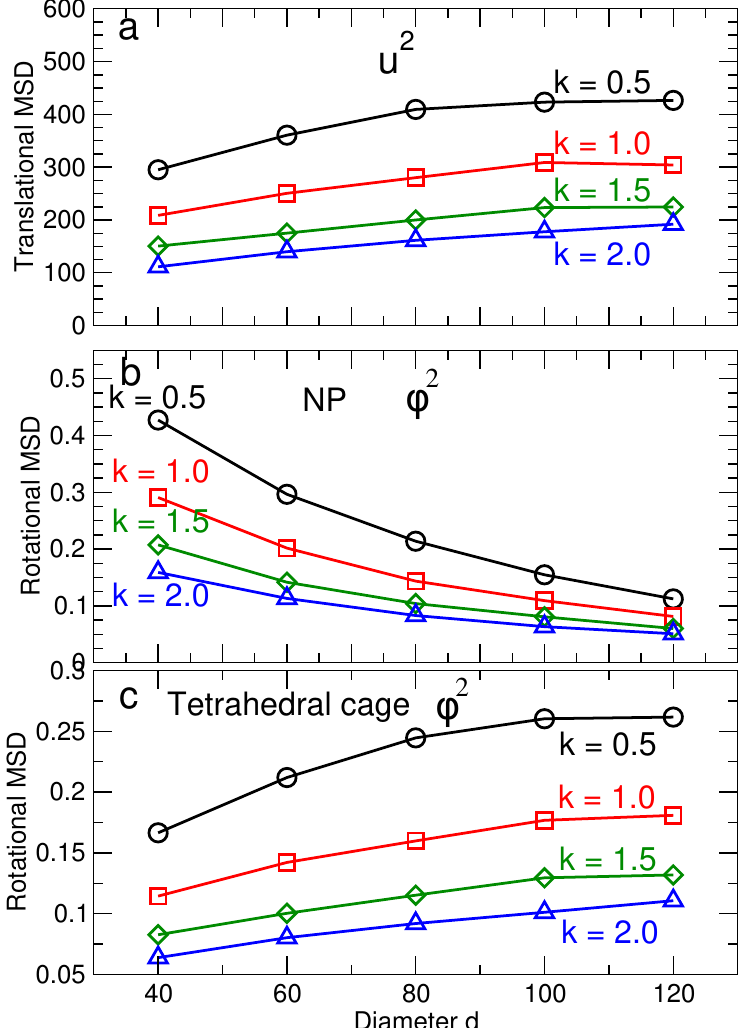
Figure 8. ( a ) The characteristic translational MSD (cid:104) u 2 (cid:105) of the NPs and tetrahedral cages as a function of NP size for different DNA stiffness. ( b ) The characteristic rotational MSD (cid:104) φ 2 (cid:105) of NPs as a function of NP size for different DNA stiffness. This decrease in (cid:104) φ 2 (cid:105) is the main factor decreasing the stability the CD lattice. ( c ) The rotational MSD (cid:104) φ 2 (cid:105) of tetrahedral cages as a function of NP size for different DNA stiffness values. The translational and rotational MSD decreases as the stiffness increases. The black, red, green and blue lines correspond to k a = 0.5,1.0,1.5,2.0